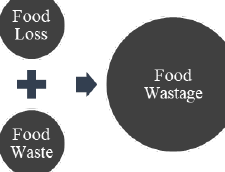
Figure 2: Equationally of food wastage